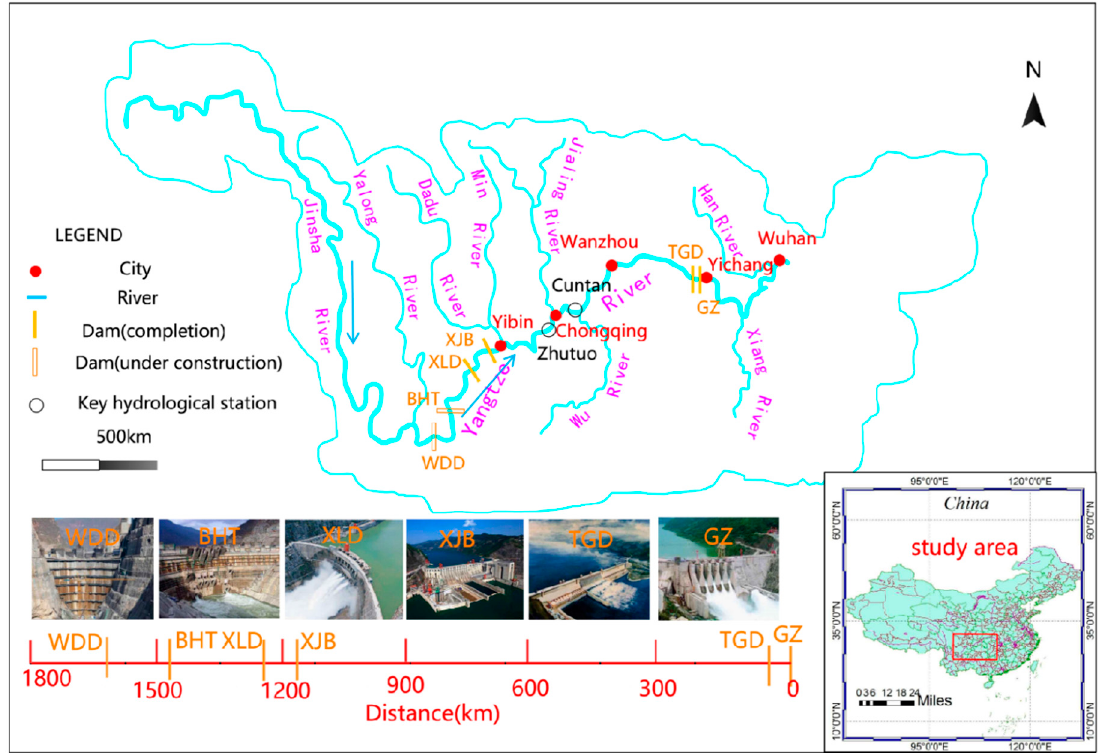
Table 1. The main characteristics of the six dams of interest and their corresponding acronyms.